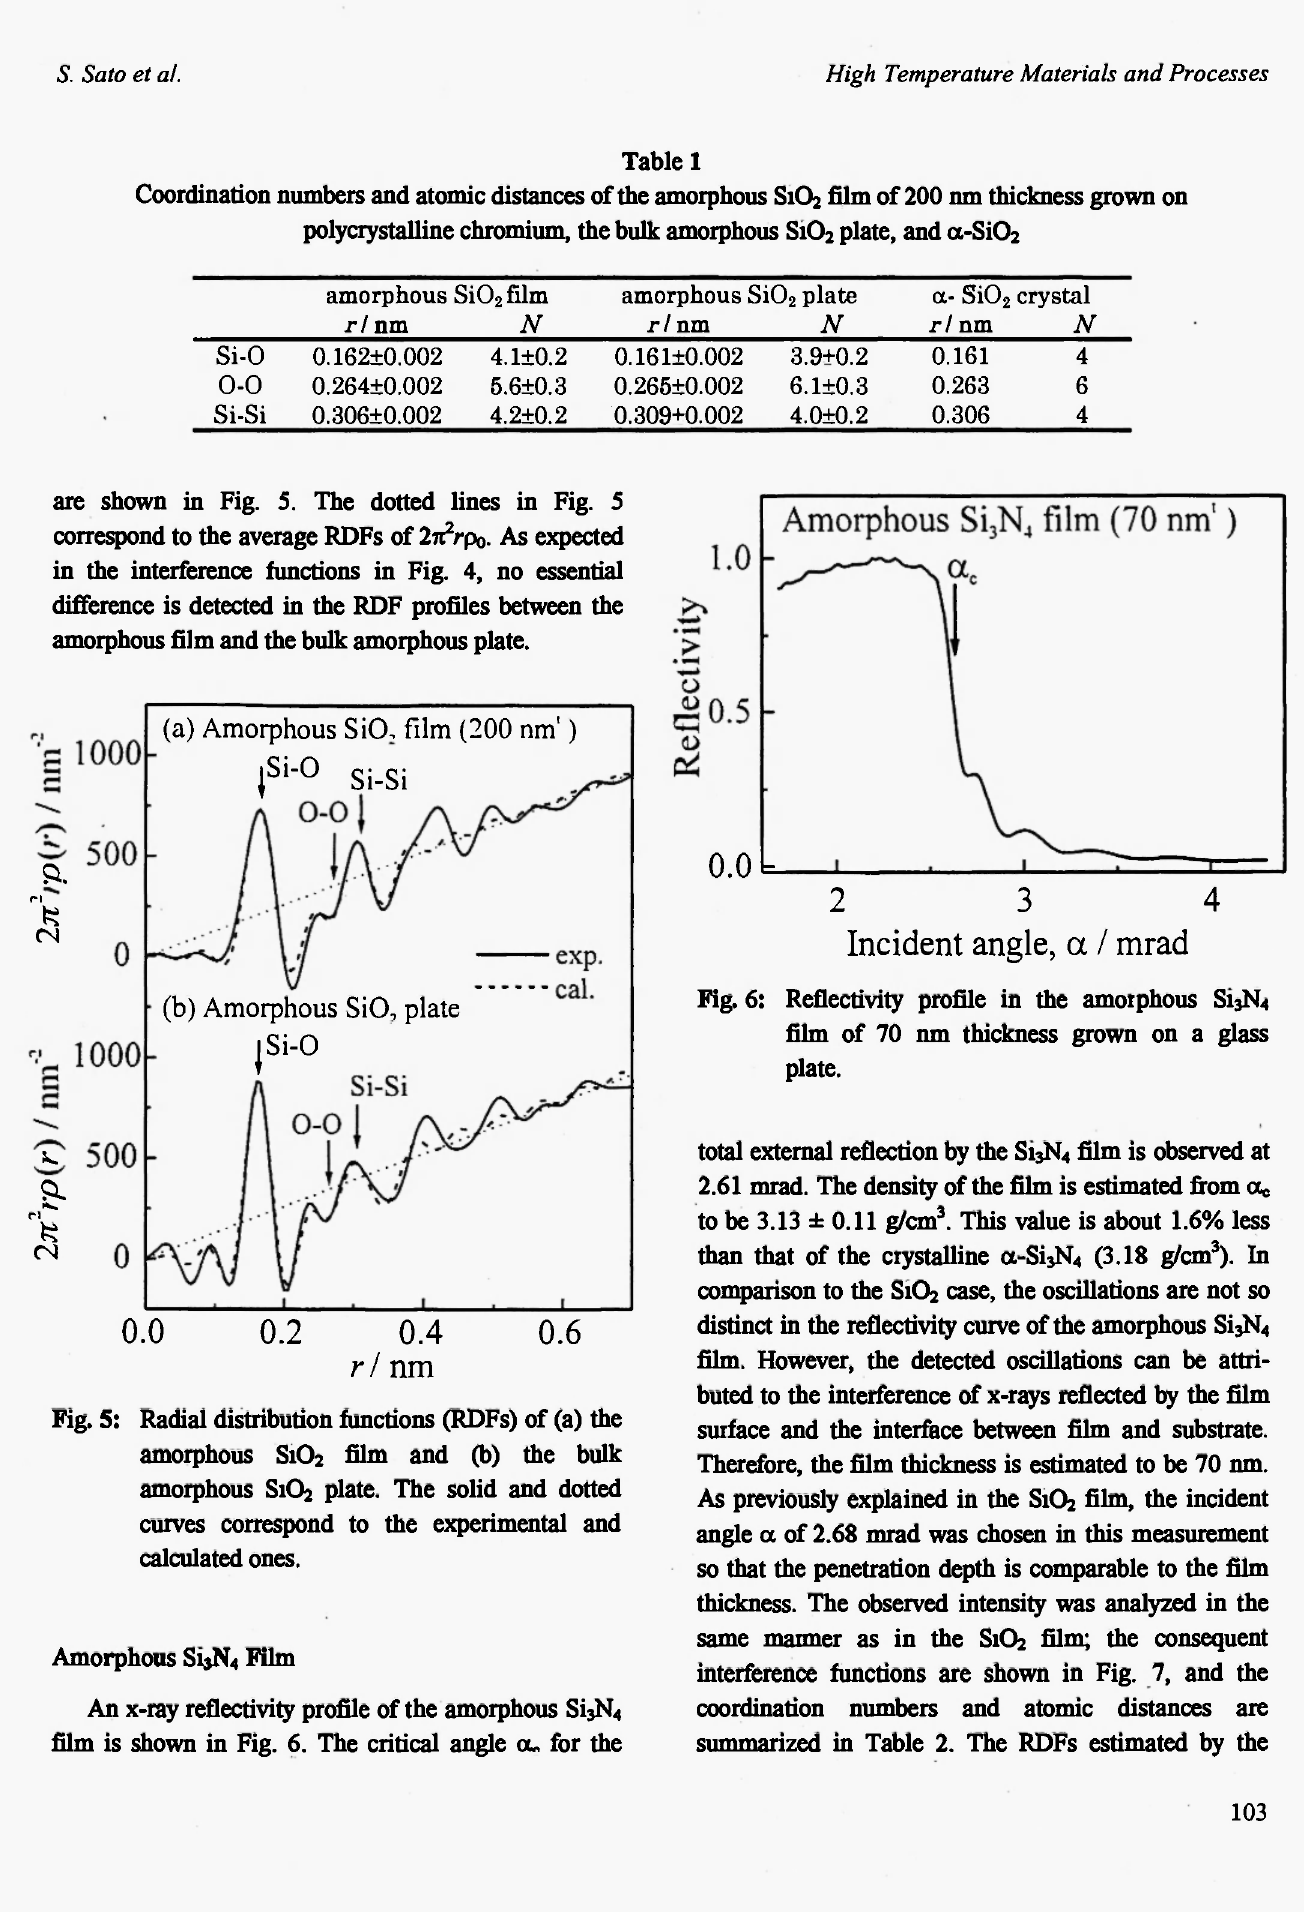
Fig. 5: Radial distribution functions (RDFs) of (a) the amorphous S1O2 film and (b) the bulk amorphous S1O2 plate. The solid and dotted curves correspond to the experimental and calculated